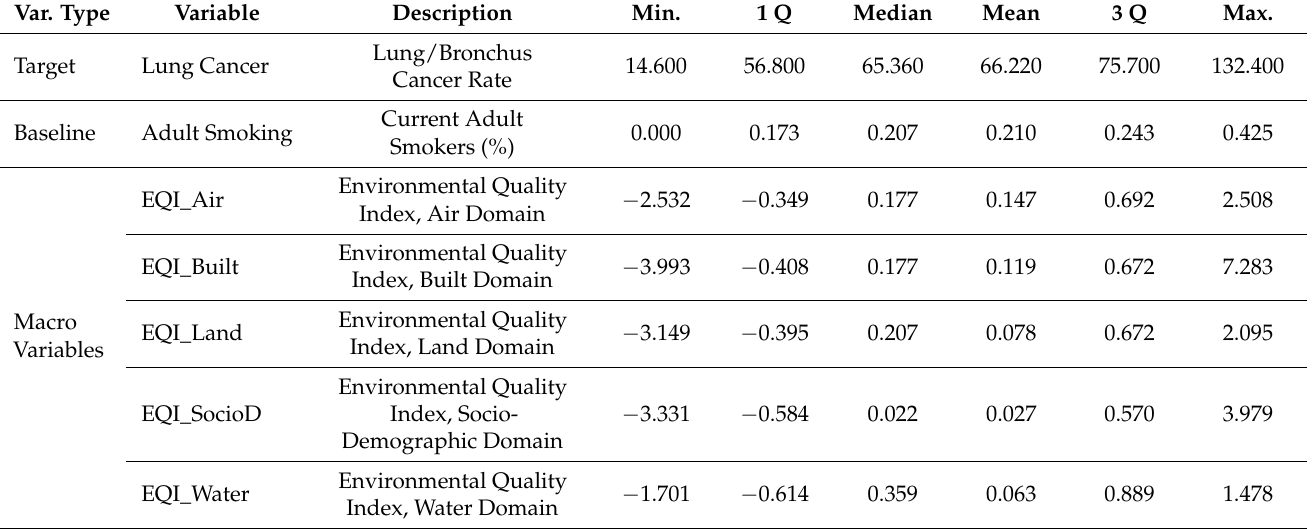
Table 4. Descriptive